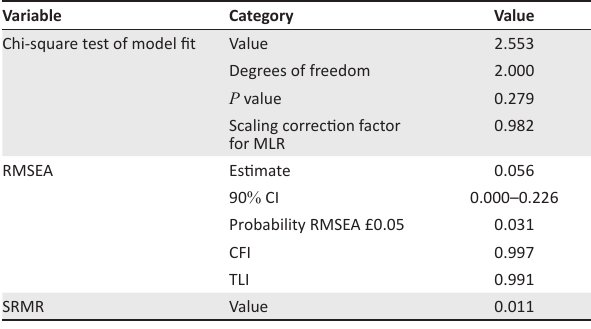
TABLE 6: Goodness-of-fit indices for the revised interaction